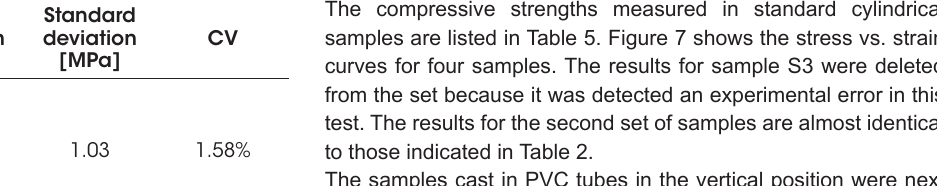
Compressive strength measured in additional conventional tests with standard samples Reference samples